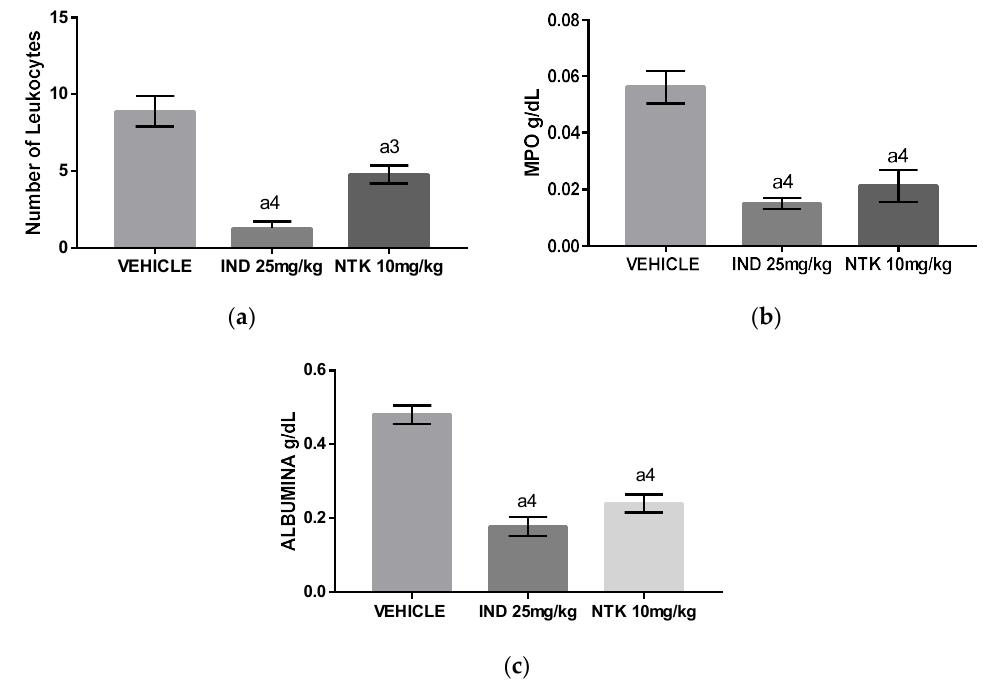
Figure 4. The effects of NTK on carrageenan-induced peritonitis. ( a ) The number of total leukocytes; ( b ) concentrations of myeloperoxidase (MPO), and ( c ) concentrations of albumin in the peritoneal fluid of mice. a4 = p < 0.0001 vs. saline and a3 = p < 0.001 vs. saline. Statistical significance was determined with one-way ANOVA and post hoc Tukey test.